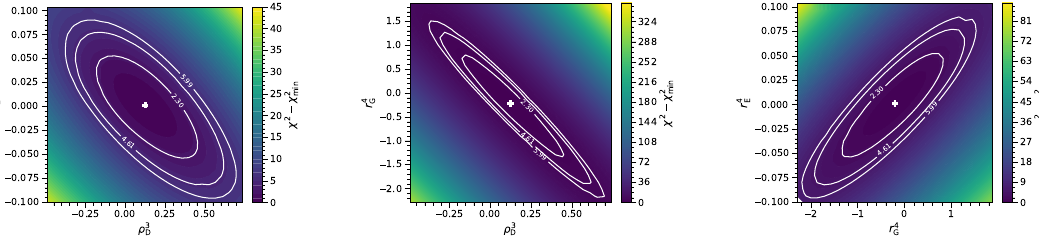
versus (left) r 4 D